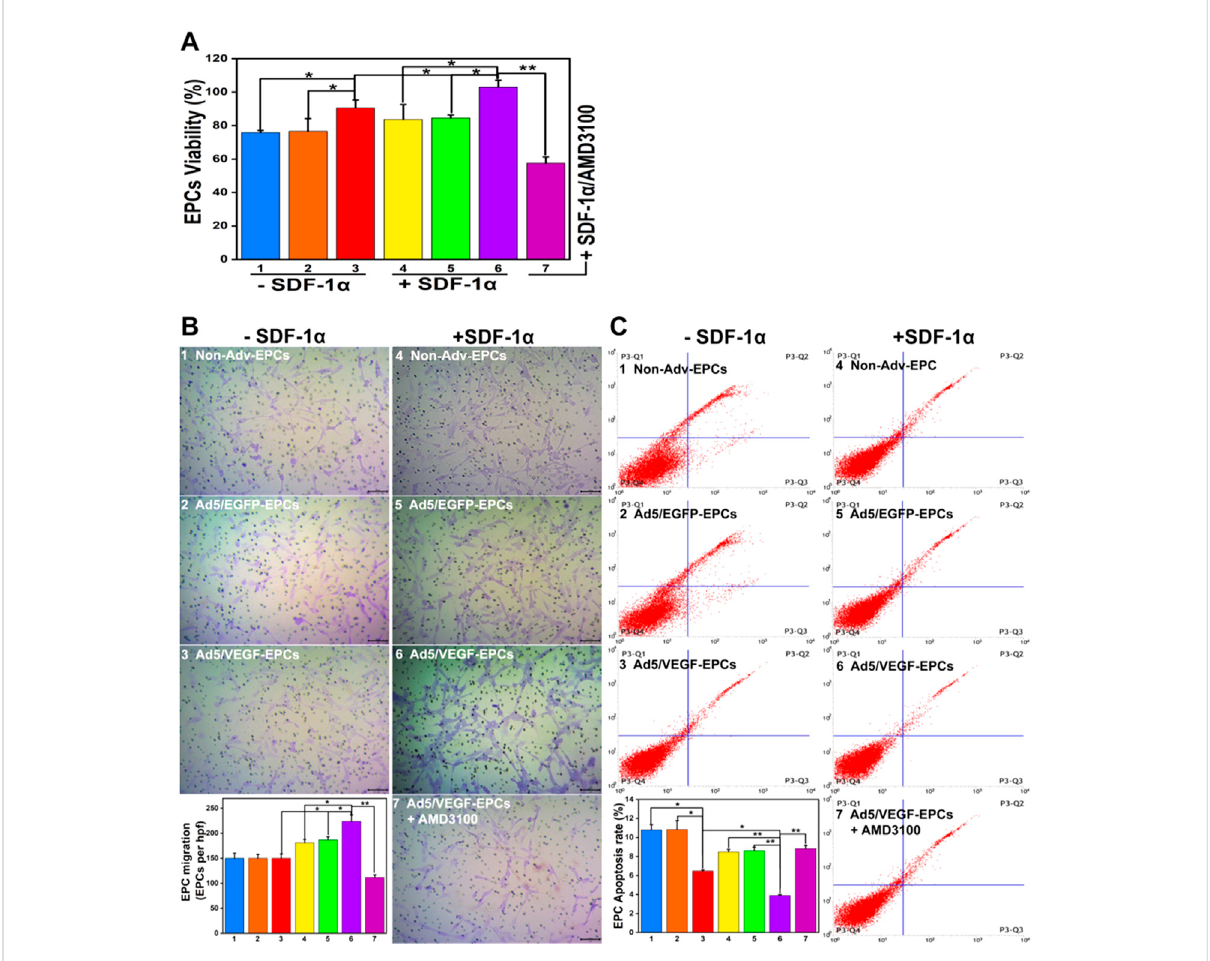
FIGURE 4 SDF-1 α improves EPC function in the co-culture model. (A) Proliferation capacity of EPCs in different groups. (B) Migration ability of EPCs. (C) Apoptosis rate of EPCs (Numbers 1 – 7 represent VSMCs and Non-Adv-EPCs; VSMCs and Ad5/EGFP-EPCs; VSMCs and Ad5/VEGF-EPCs; SDF-1 α + VSMCs and Non-Adv-EPCs; SDF-1 α + VSMCs and Ad5/EGFP-EPCs; SDF-1 α + VSMCs and Ad5/VEGF-EPCs; SDF-1 α + VSMCs and Ad5/VEGF-EPCs + AMD3100 respectively. * p < 0.05, ** p < 0.01, n = 3 per group.).